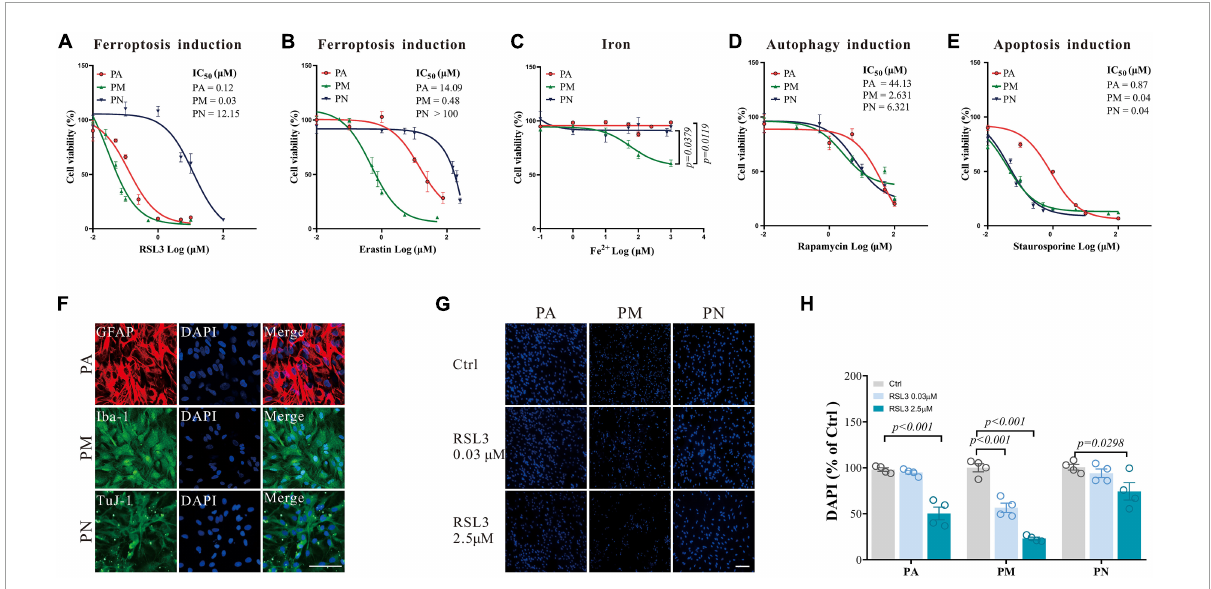
FIGURE1 The response of primary brain cells to cell death inducers. (A–E) Dose-response curves of ferroptosis-inducers RSL3 (A) or erastin (B) , Fe 2 + (C) , autophagy-inducer rapamycin (D) , and apoptosis-inducer staurosporine (E) on primary brain cells after 24 h treatment, detected by CCK8, respectively N = 6. (F) Brain cells in the monoculture systems were stained with Iba-1 (green), TuJ-1 (green), GFAP (red), and DAPI (blue), respectively. (G) Brain cells in the monoculture systems were stained with DAPI (blue) after RSL3 treatment for 24 h, respectively. (H) The quantification of the proportion of DAPI in primary brain cells in the monoculture systems. Data are means ± SEM, N = 4, scale bar = 100 µ m. One-way ANOVA with post hoc Tukey test was performed.